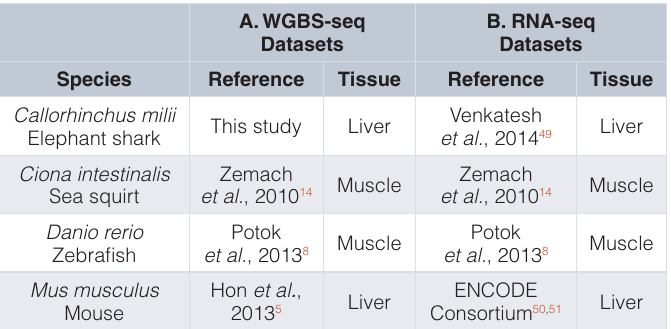
Table 1. Published WGBS-seq and RNA-seq datasets used for comparative analysis in this study. Accession numbers are provided in the